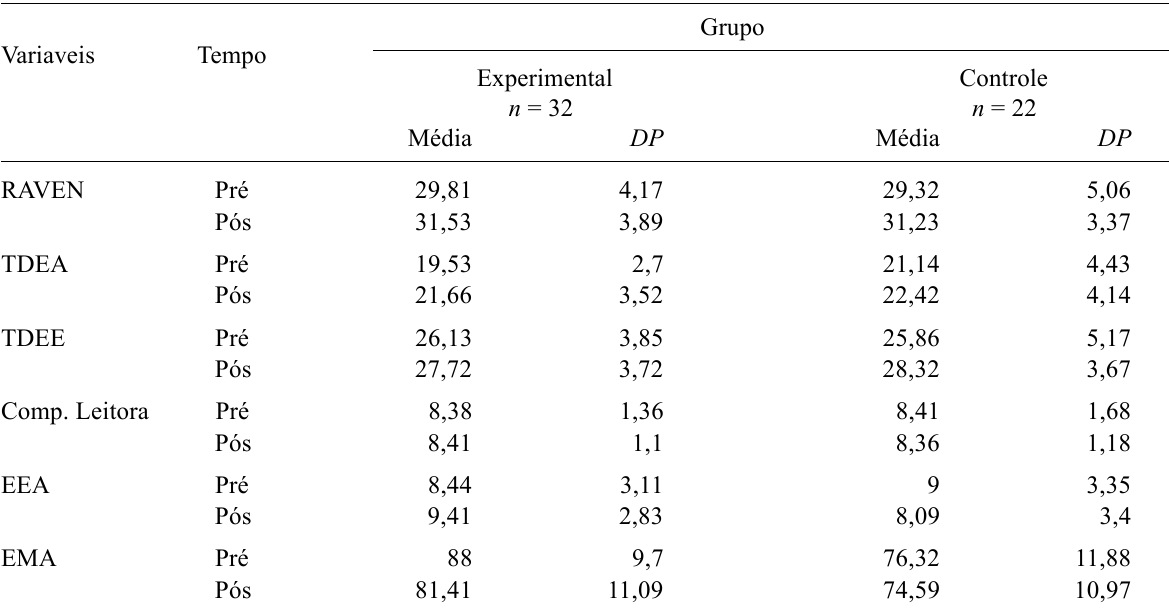
Notas . Raven = Teste de Matrizes Progressivas de Raven; TDEA = Teste de desempenho escolar de aritmética; TDEA = Teste de desempenho escolar de escrita; Comp.Leitura = Compreensão Leitora; EEA = Escala de Estratégias de Aprendizagem; EMA = Escala de Motivação para a